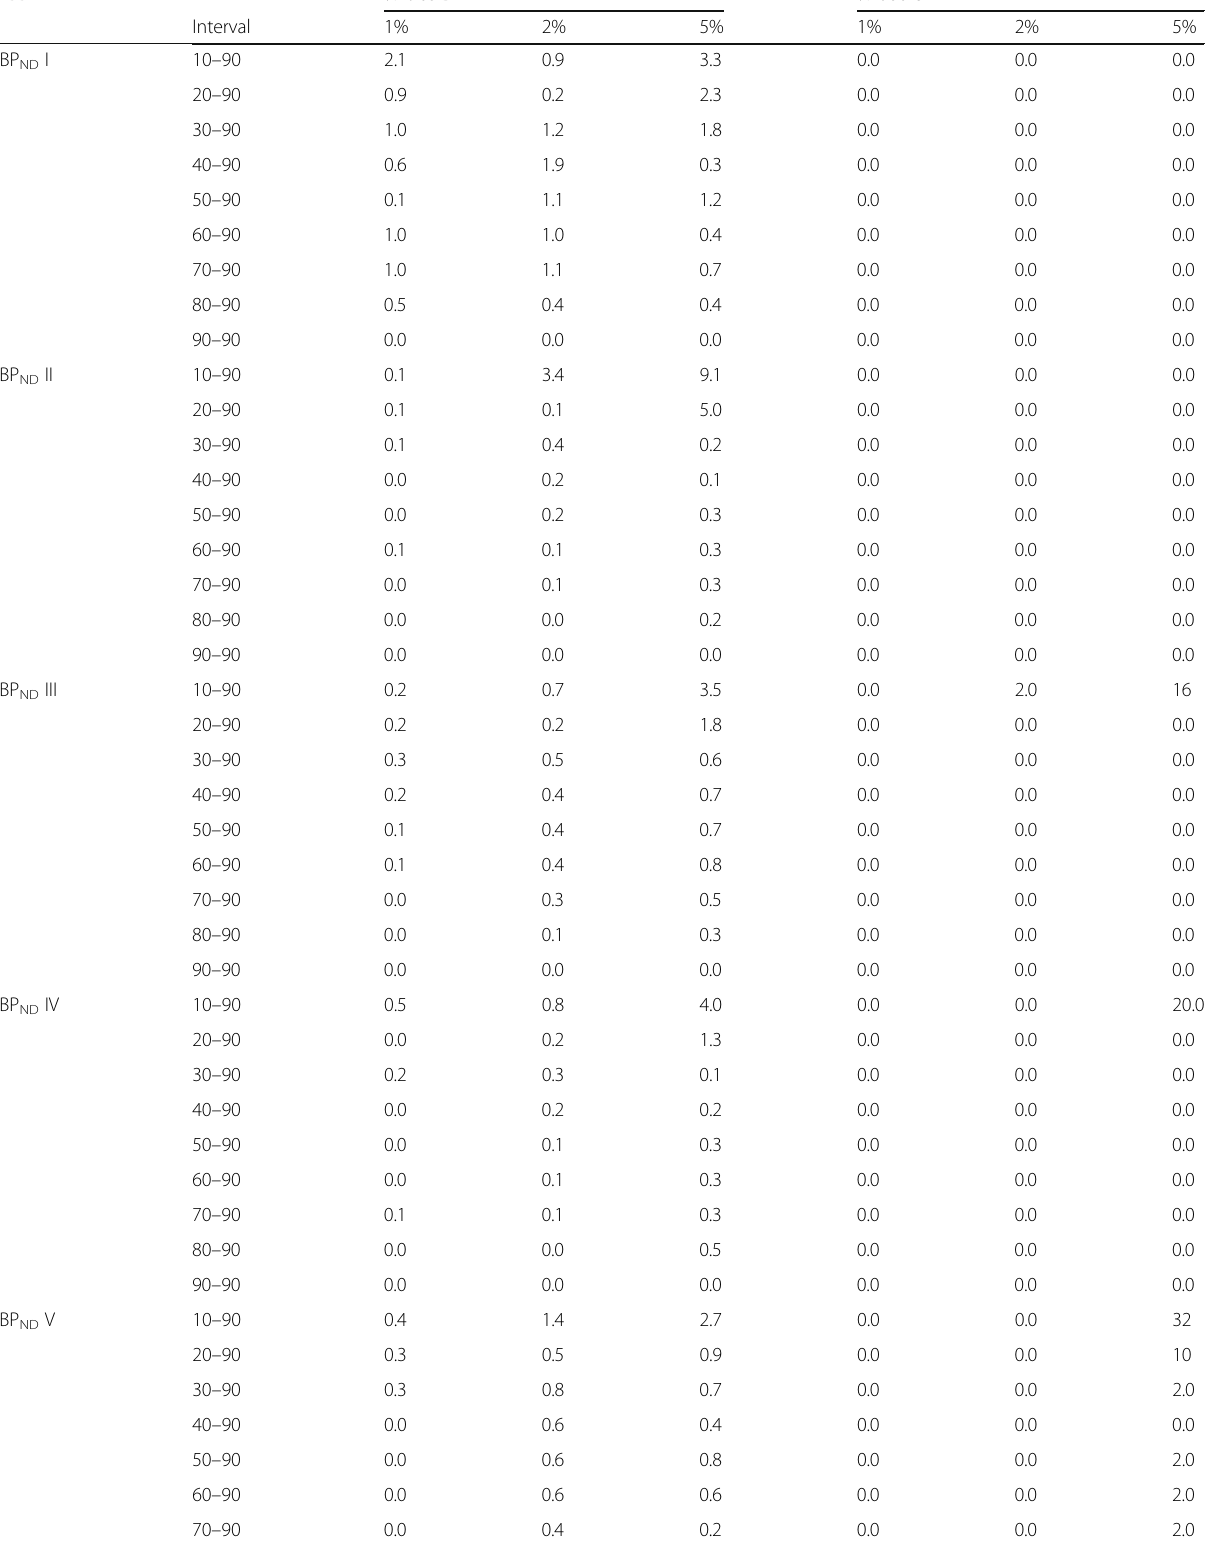
Table 4 Bias in DVR and outliers as a result of noise and the dual-time-window protocol for SRTM-generated [ 18 F]florbetaben TACs